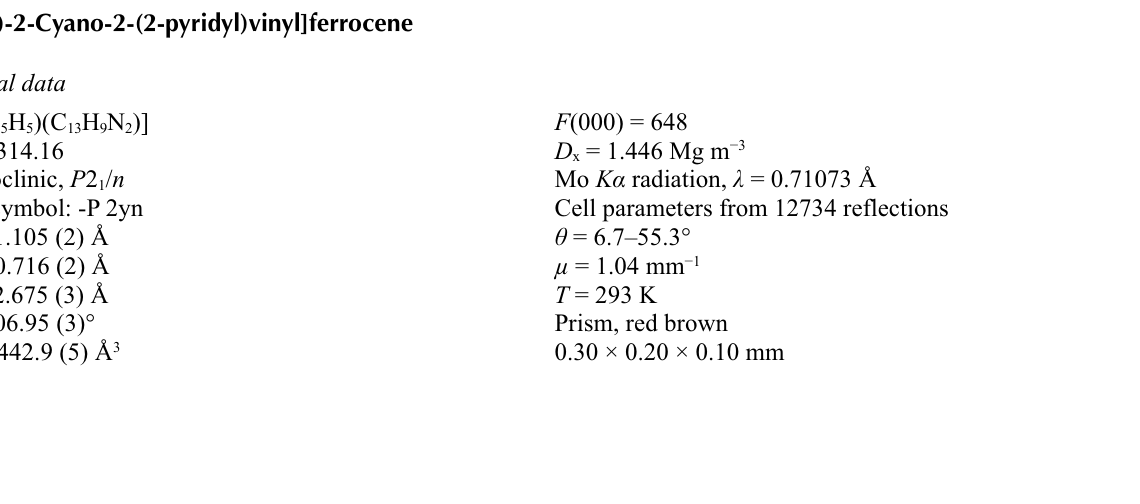
The packing diagram of the title compound, viewed along the a